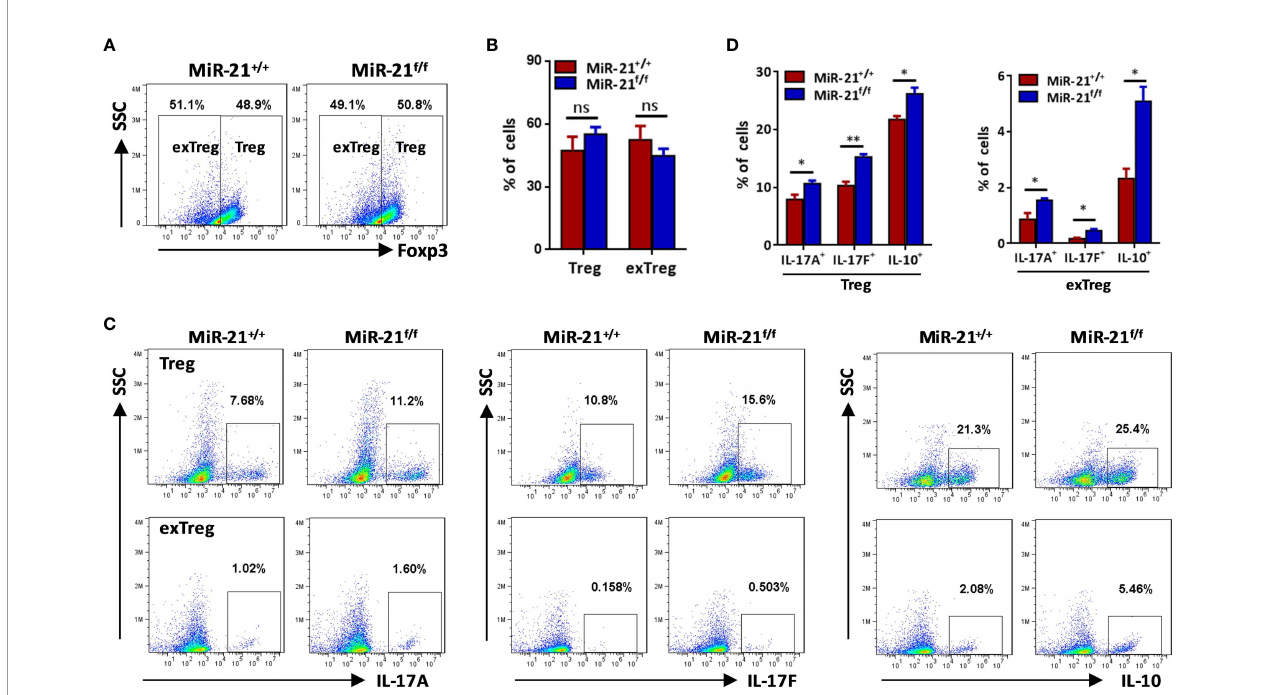
FIGURE 3 | The proportions of IL-17 + and IL-10 + cells were signi fi cantly increased by both exTregs and Tregs that lacking miR-21. CD4 + CD8 - YFP + cells were fl ow sorted from the spleen of Foxp3 Cre-YFP miR-21 +/+ (MiR-21 +/+ ) and Foxp3 Cre-YFP miR-21 f/f (MiR-21 f/f ) mice (n=5). Cells were stimulated with anti-CD3 plus anti-CD28 in the presence of Th17 priming cytokines. After 72 h, cells were treated with PMA plus ionomycin in the presence of GolgiStop for 4 h. Cells were then fi xed, permeabilized, and stained with anti-Foxp3, anti – IL-17A, anti – IL-17F, anti – IL-10, and examined by fl ow cytometry. The proportions of Foxp3 + (Treg) and Foxp3 - (exTreg) cells among total live cells were shown in (A, B) . In addition, the proportions of IL-17A + , IL-17F + and IL-10 + cells among Foxp3 + (Treg) and Foxp3 - (exTreg) cells were also examined by fl ow cytometry (C) and the quanti fi cation of those results was shown in (D) . Data are representative of three separate experiments. ns, no signi fi cance. *p < 0.05, **p <